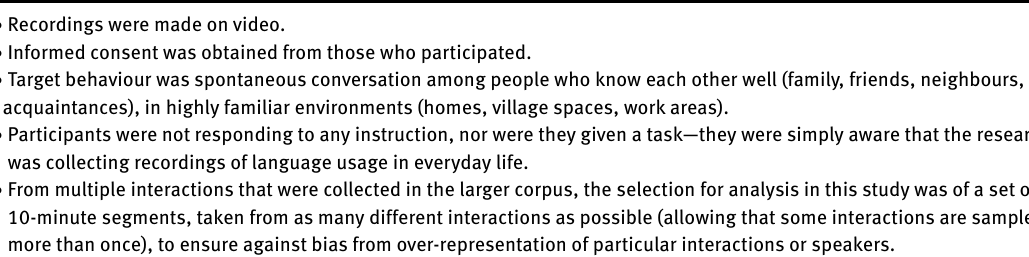
Table 1: Key properties of the data collected for the studies in this